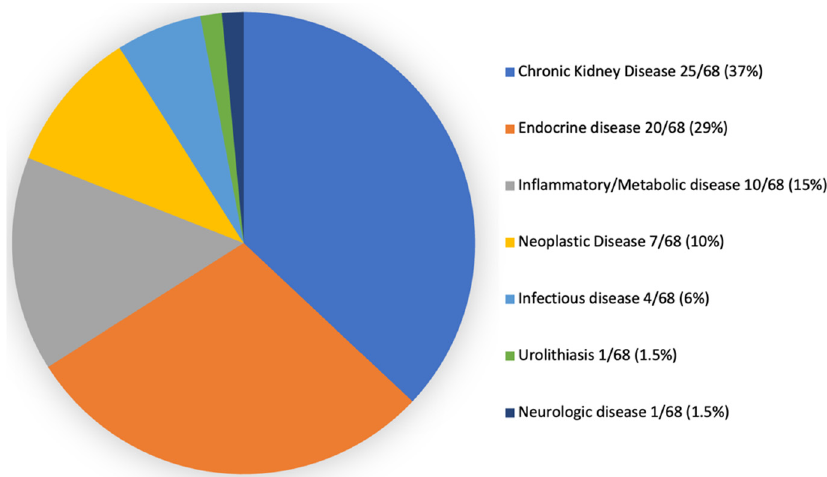
Figure 3. Final diagnosis in clinically ill cats noticed with adrenomegaly. Comparing the frequency of endocrine (20/68; 29%) versus non-endocrine cases (48/68; 71%), the later were over-represented ( p < 0.001). Adrenomegaly was bilateral in 36/68 (53%) of the cases, and unilateral with normal- sized contralateral adrenal gland in 32/68 (47%). There was no statistically significant difference in the prevalence of bilateral enlargement as opposed to unilateral ( p = 0.628). Of the 32 unilateral cases, 23 (72%) were on the left and 9 (28%) on the right. This apparent difference in regional enlargement of the adrenals was statistically significant ( p = 0.013). Although all 68 cases had adrenal gland measurements within the medical records, stored images were only available for 64/68 cases (94%). Detailed findings are shown in Table 2. Concerning left adrenal gland findings, it was mainly oval shaped with a mean dorsoventral axis (height) size of 5.5 ± 0.8 mm, with regular limits, without cortical- medullary differentiation, and without hyperechogenic foci and focal lesions. It demonstrated mixed echogenicity and homogeneous echotexture. By contrast, the right adrenal gland tended to take on a bipolar shape without corticomedullary differentiation. It had an average height of 5.1 ± 0.9 mm, with regular limits. The right adrenal gland was also hypoechogenic, homogeneous, and without hyperechogenic foci and focal lesions. The left adrenal gland tended to be larger ( p = 0.005) and more ovoid in shape ( p = 0.005) as compared to the right adrenal gland. However, despite the differences in dimension between left and right, the magnitude of this difference was small (Cohen’s d = 0.35). Table 2. Ultrasound findings of the left and right adrenals in clinically ill cats showing adrenomegaly (either uni or bilateral). Characteristics